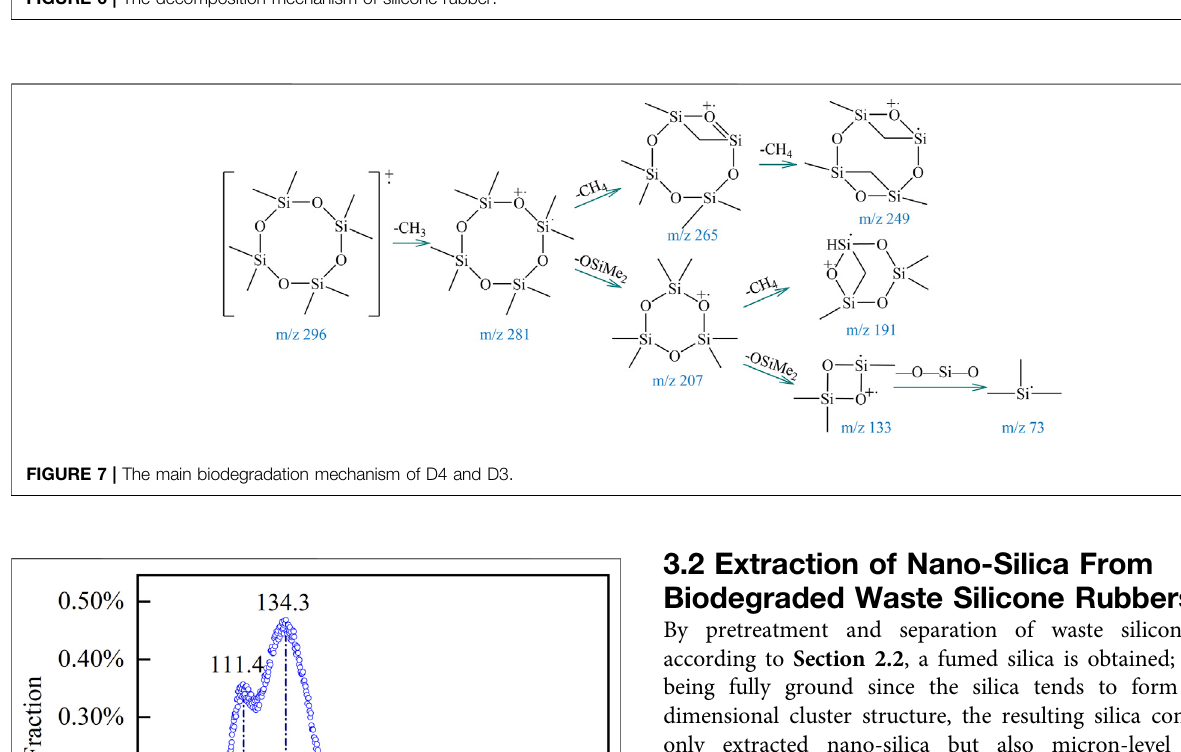
FIGURE 6 | The decomposition mechanism of silicone rubber.